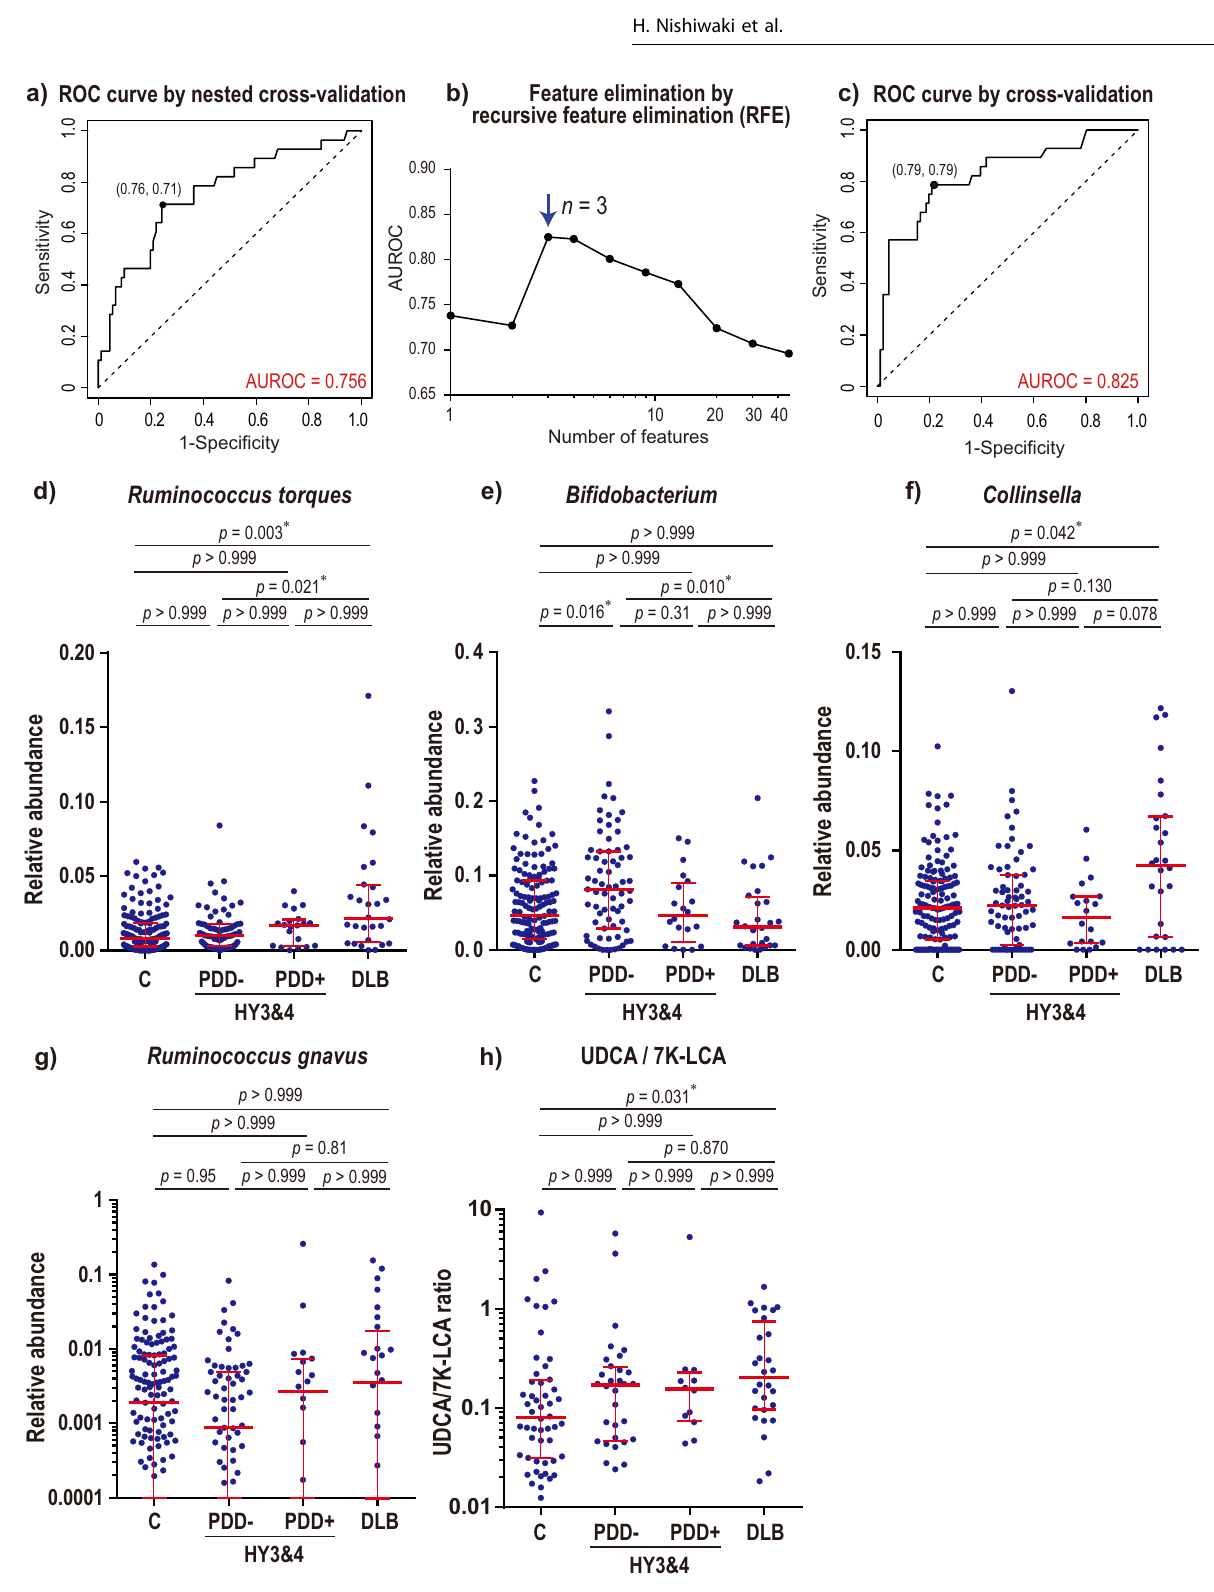
(Supplementary Table 8). Six of the seven decreased genera excluding Haemophilus were SCFA-producing bacteria. Genera that were signi fi cantly decreased in DLB were similar to those in PD (Supplementary Tables 2a, 3a). Decreases of SCFA-producing bacteria have been repeatedly reported in PD 20,24,26 , Alzheimer ’ s